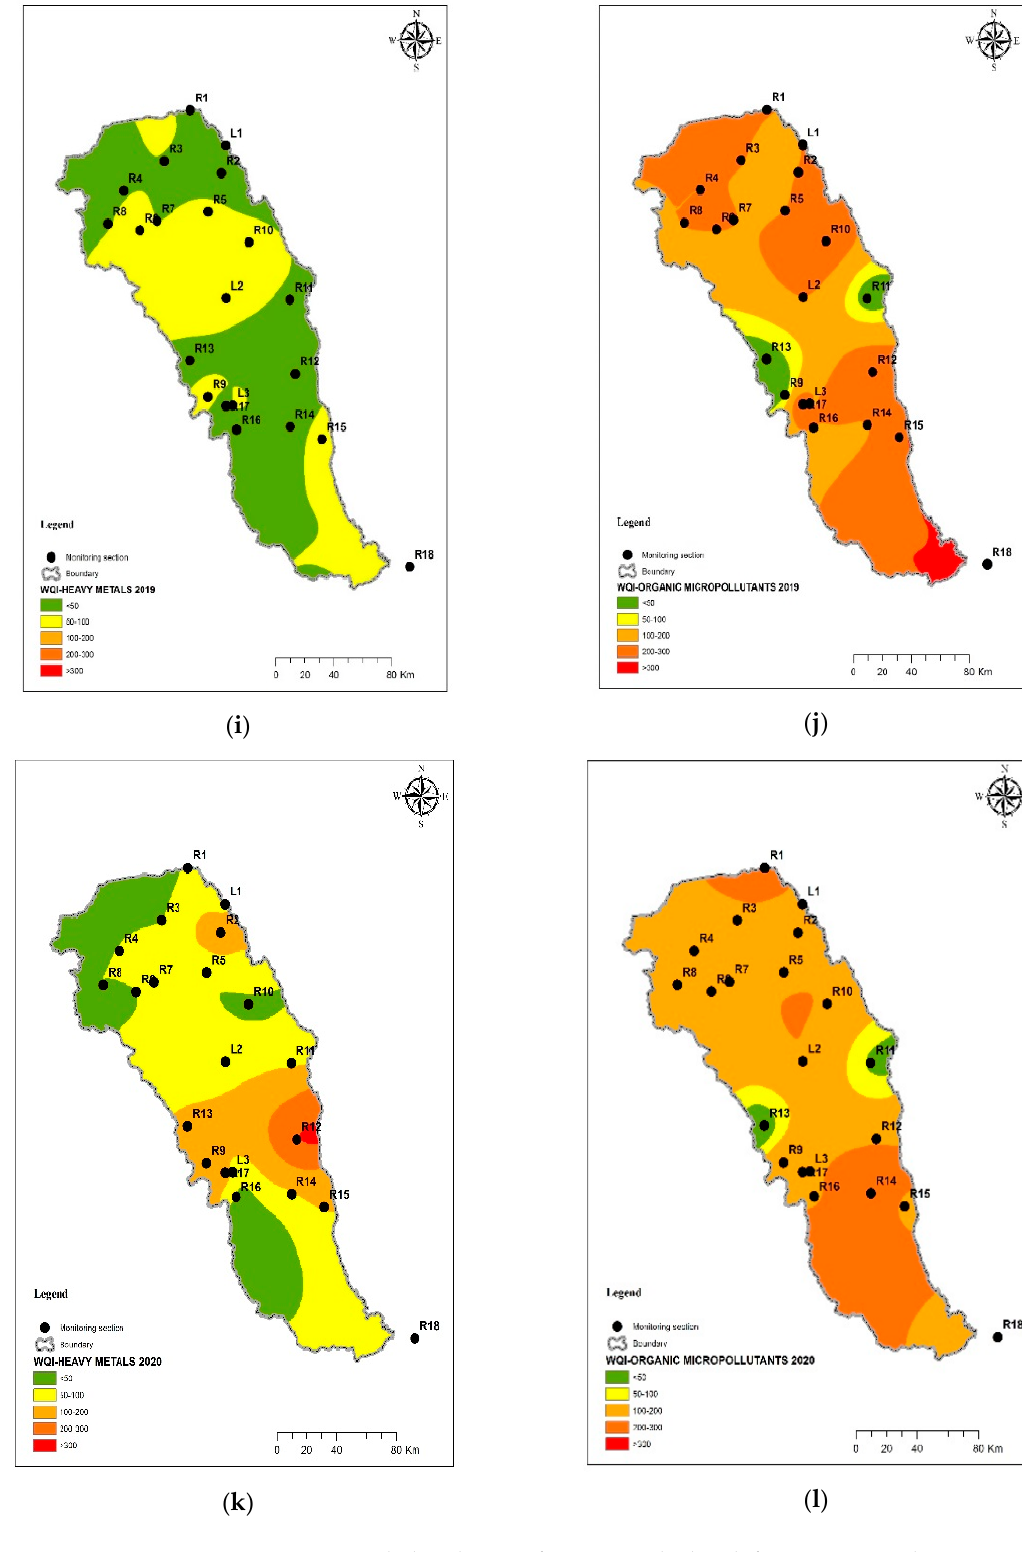
Figure 3. Spatial distribution for WQI calculated for organic and inorganic priority pollutants during 2015–2020 for Siret River basin: ( a ) 2015—HM, ( b ) 2015—OM; ( c ) 2016—HM; ( d ) 2016—OM; ( e ) 2017—HM; ( f ) 2017—OM; ( g ) 2018—HM; ( h ) 2018—OM; ( i ) 2019—HM; ( j ) 2019—OM; ( k ) 2020—HM; ( l ) 2020—OM.